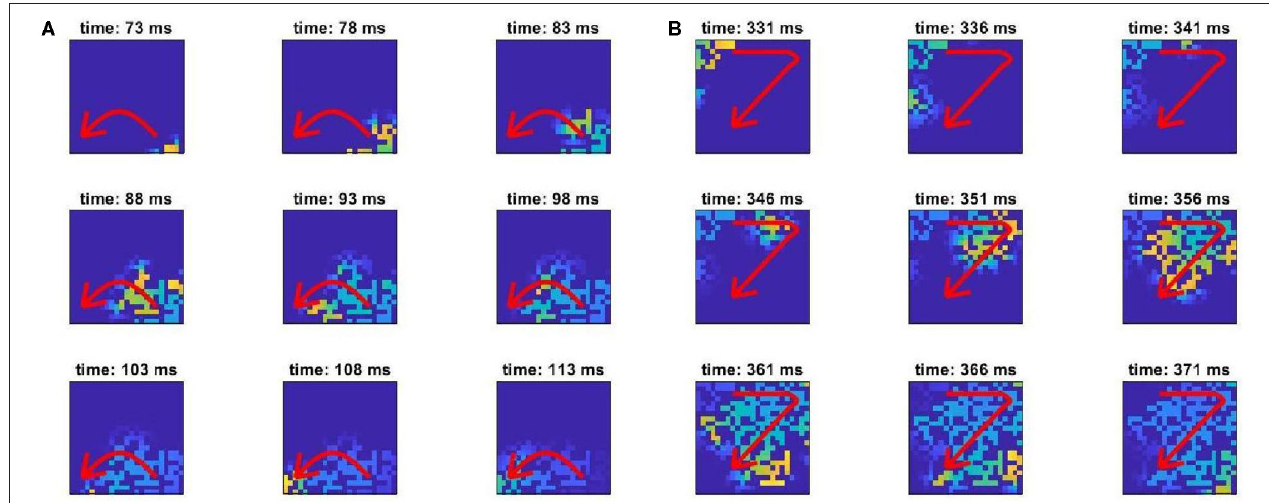
FIGURE 3 | Snapshots of AP propagation demonstrating an event of the unidirectional block. Visualised is one section of the full fibrotic region, detected by our RVI-based approach. The brightness of colour indicates level of activation, and the red arrows indicate the overall direction of propagation. (A) The wave propagates from the bottom-right to the bottom-left corner of the section, attempting also to propagate through the central passage but failing due to an imbalance between excited and excitable tissue. (B) When the wavefront later propagates through the top portion of this structure, it is able to successfully propagate downwards through the central passage, re-entering into the tissue in the bottom portion.